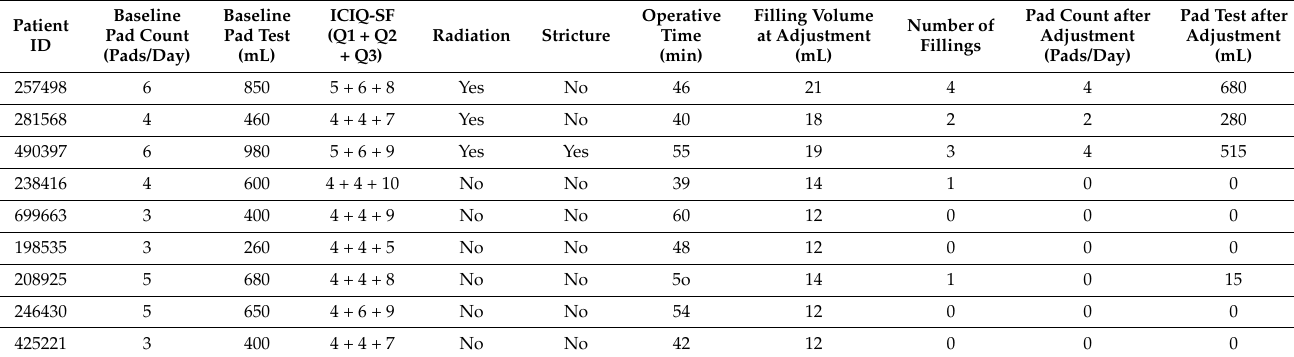
Table 3. Clinical data of patients included in the study, including baseline, operative, and postoperative information. Patient